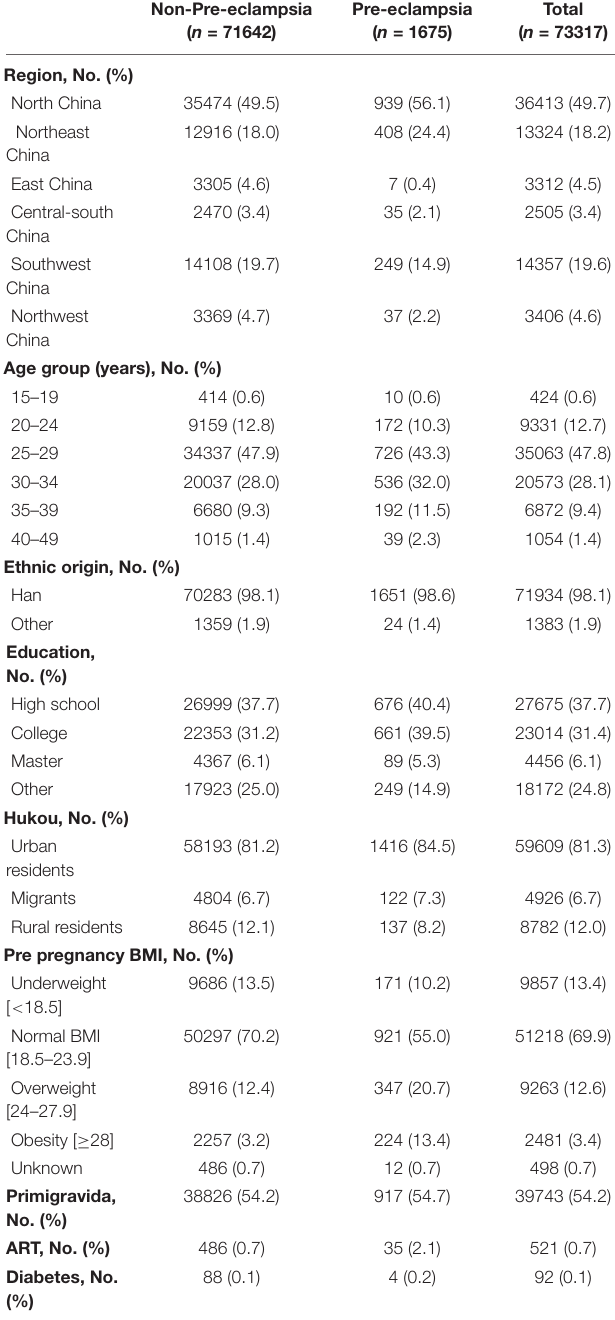
TABLE 1 | Basic characteristics of